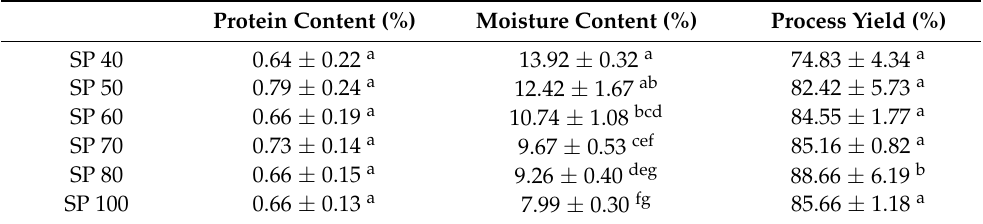
Table 1. Product specifications and process yield of spray-dried waxy rice starches. Values denoted with different alphabets in the same column are significantly different ( p <